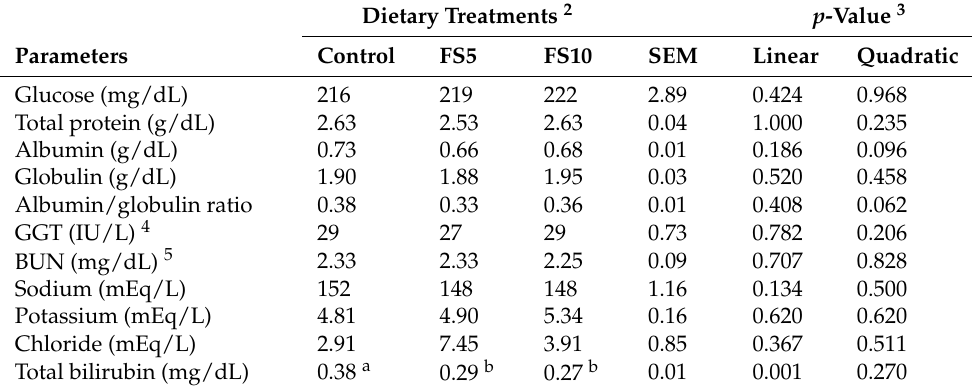
Table 6. Effect of the dietary inclusion of different levels of fenugreek seed (FS) on the serum biochemistry of the broiler chickens 1